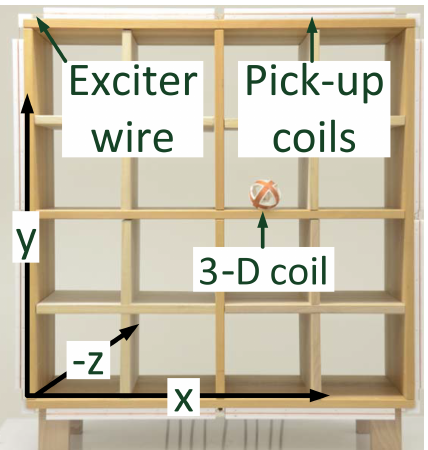
Figure 1. Shelf with the exciter wire, eight pick-up coils around the shelf and a 3-D coil in one compartment.